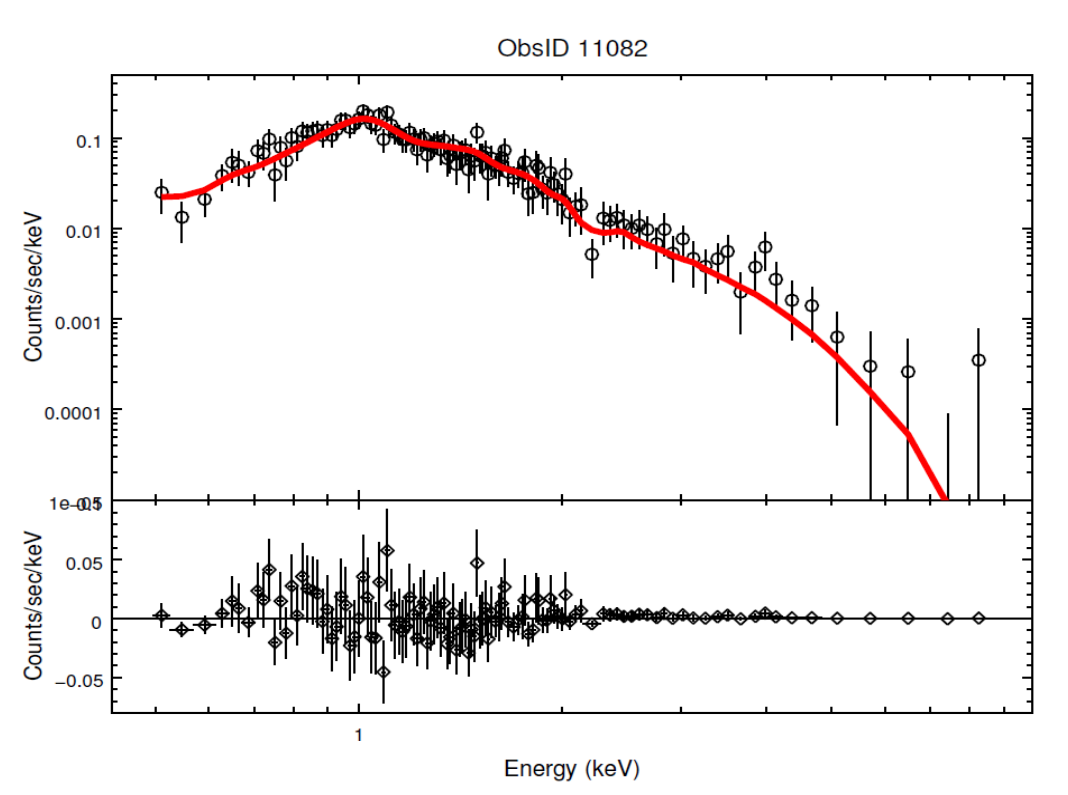
Figure 8. TV Cas Spectrum from Chandra Observation ID